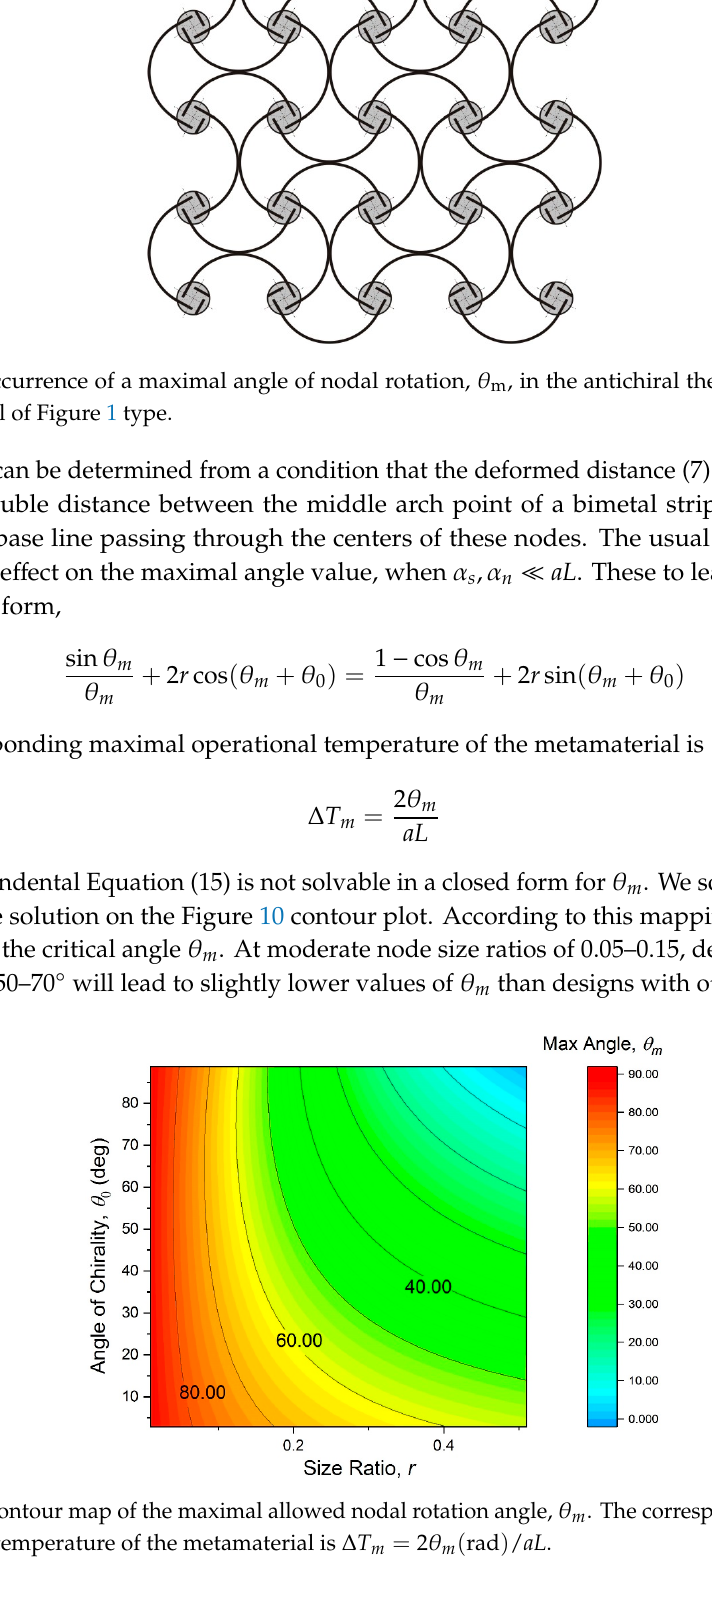
design parameters ( 𝜃 (cid:2868) , 𝑟, and 𝑎𝐿 ).